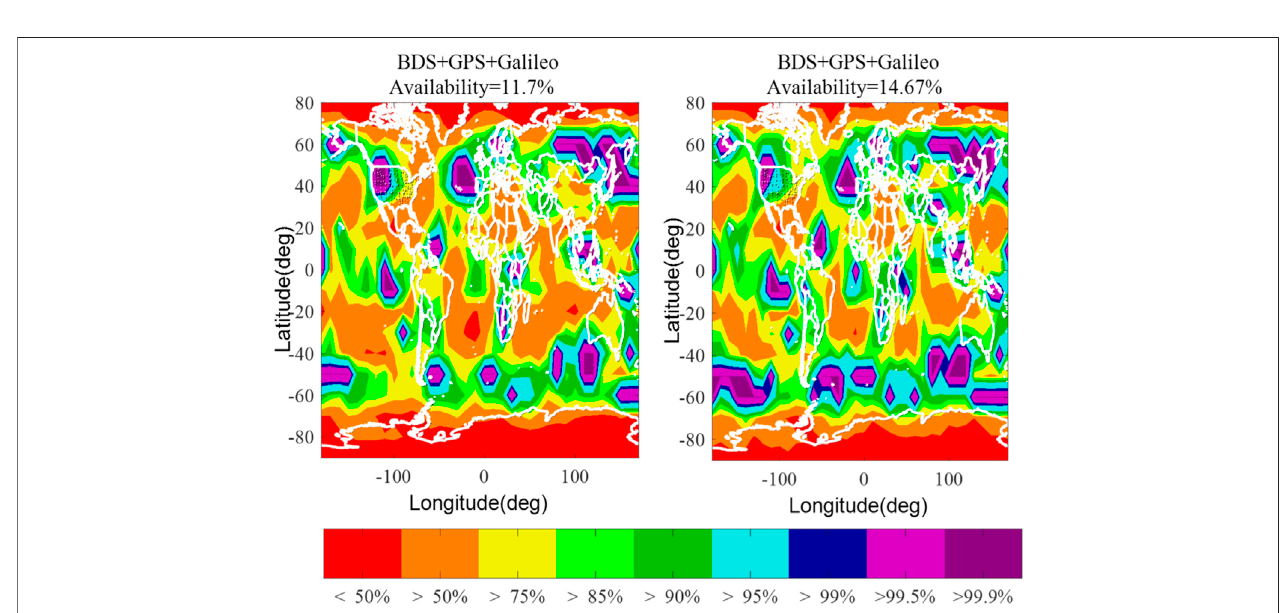
FIGURE 8 | Availability before and after three-constellation optimization under the condition of VAL = 20